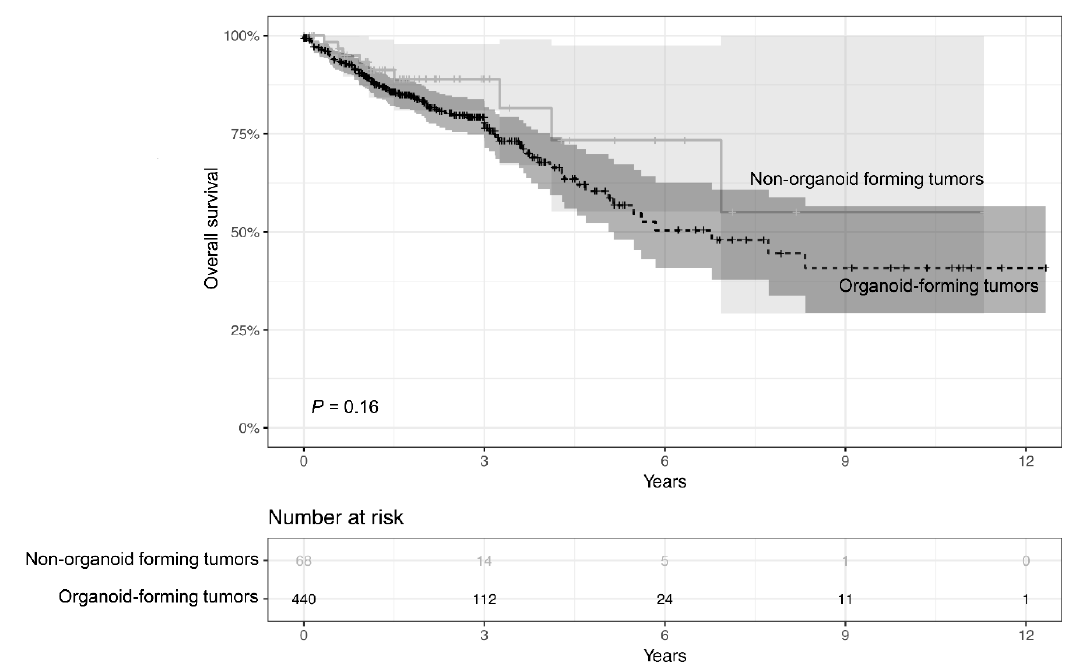
Figure 5. Kaplan–Meier survival analysis of patients according to organoid establishment status in the TCGA database. The overall survival of patients with organoid-forming versus non-organoid-forming tumors is shown.